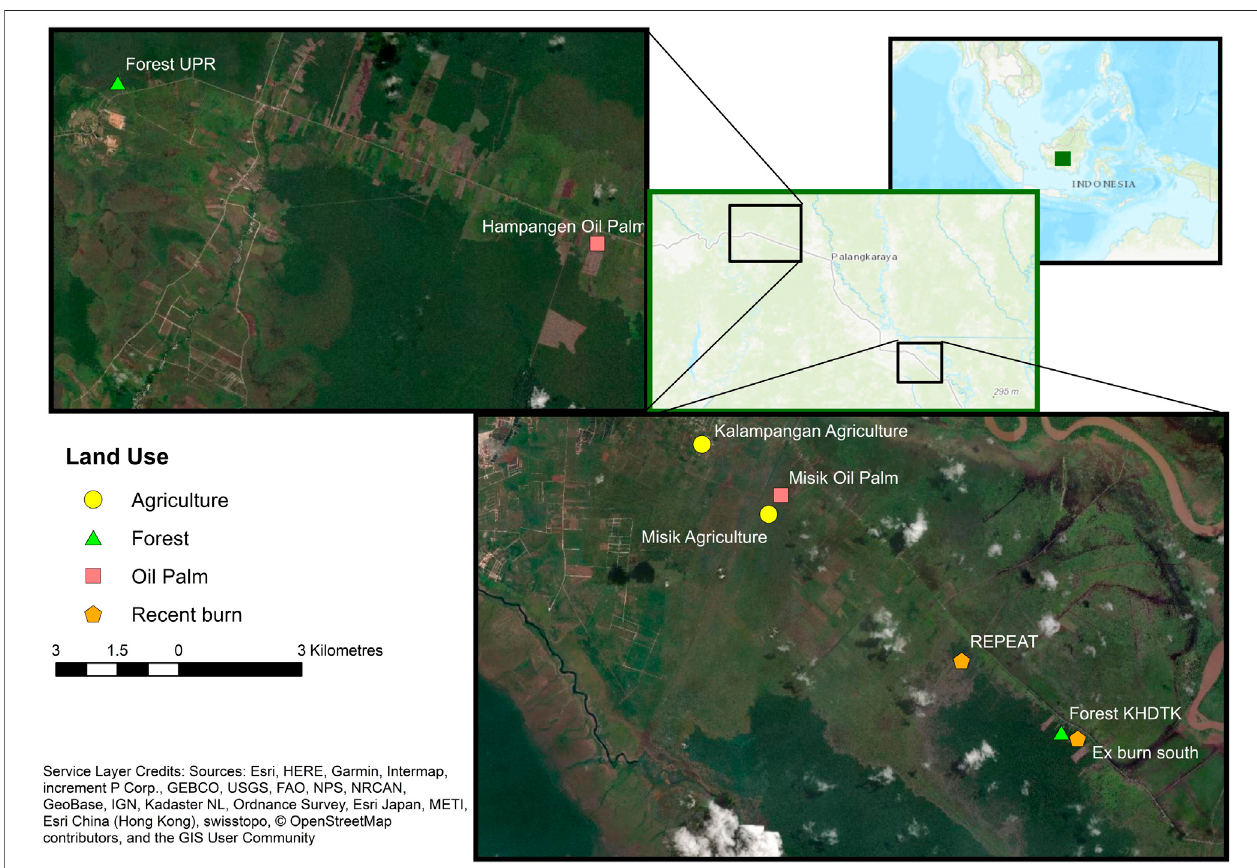
FIGURE 3 | Study site locations, Central Kalimantan.